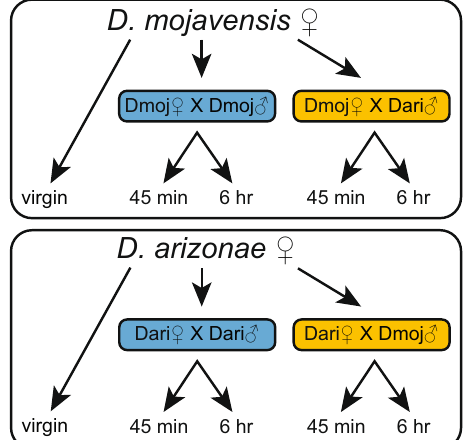
Fig. 2 Experimental design used for differential expression and alternative splicing as a response to conspeci fi c (blue) and heterospeci fi c (yellow) matings in D. mojavensis and D. arizonae . RNA- seq libraries were constructed from LRT of virgins, con- and heterospeci fi cally mated females at 45 min and 6 h postmating. All comparisons were performed between virgin females and mated females for each